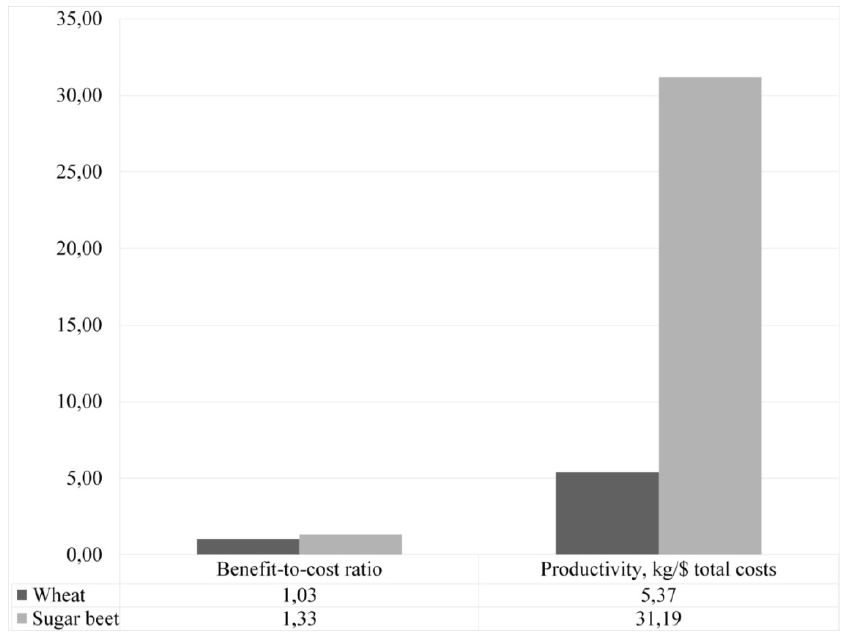
Figure 1. Main economic indicators of the sugar beet and wheat production system.